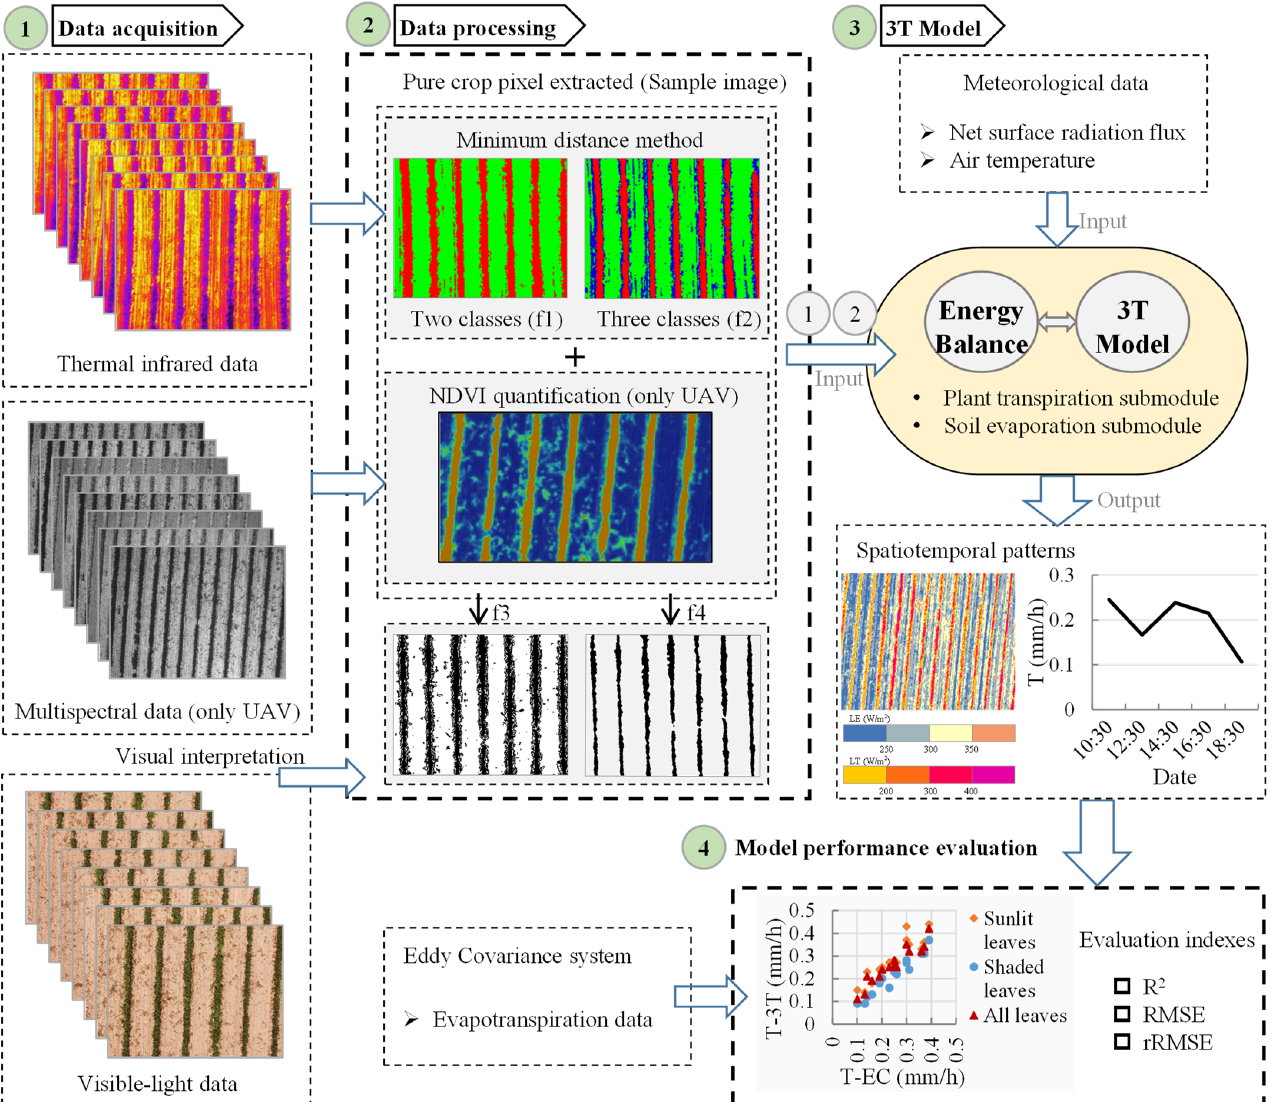
Figure 4. The schematic diagram of data processing for ET estimation.